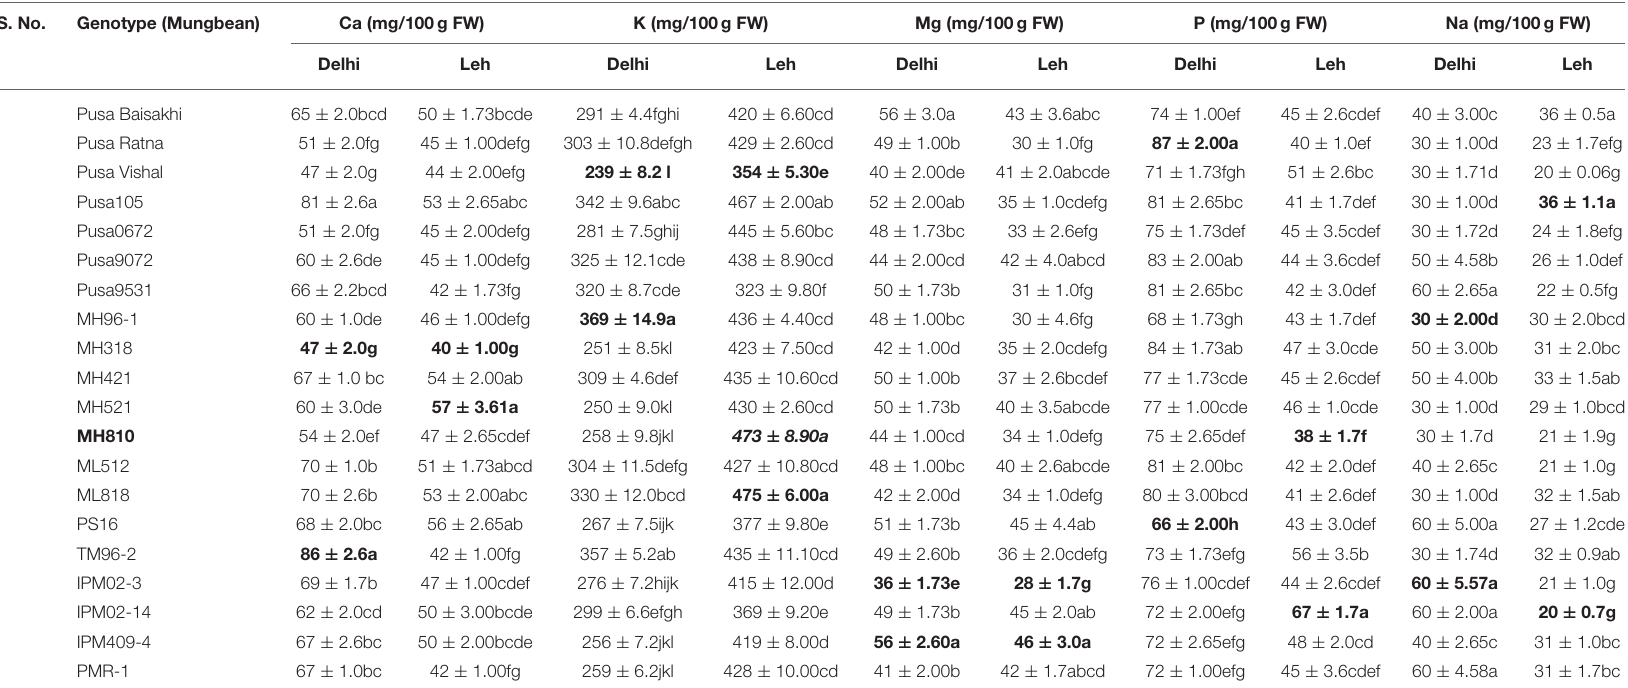
Values are expressed as mean ± SD (n = 3), and different letters indicate a significant difference (p ≤